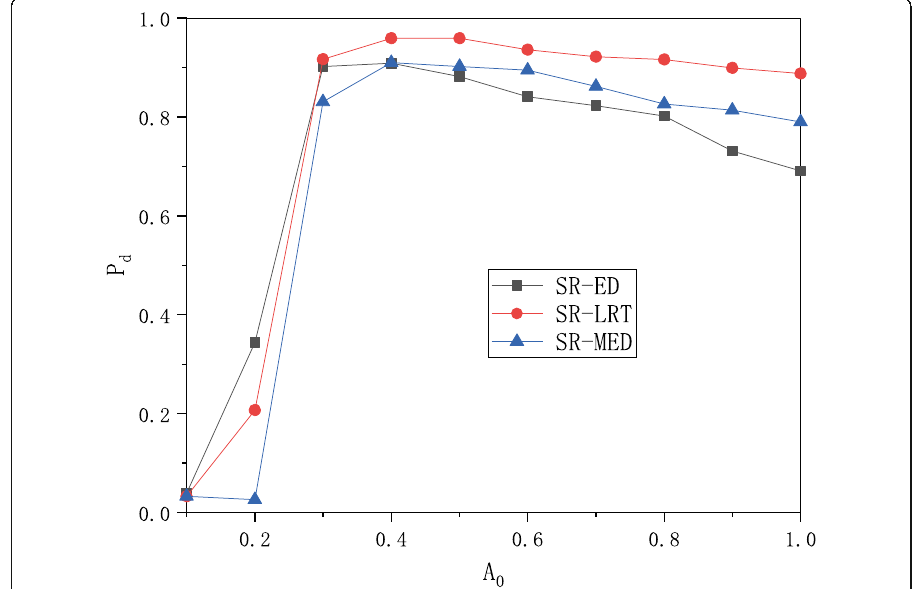
Fig. 4 The detection probability P d versus normalized amplitude A 0 with